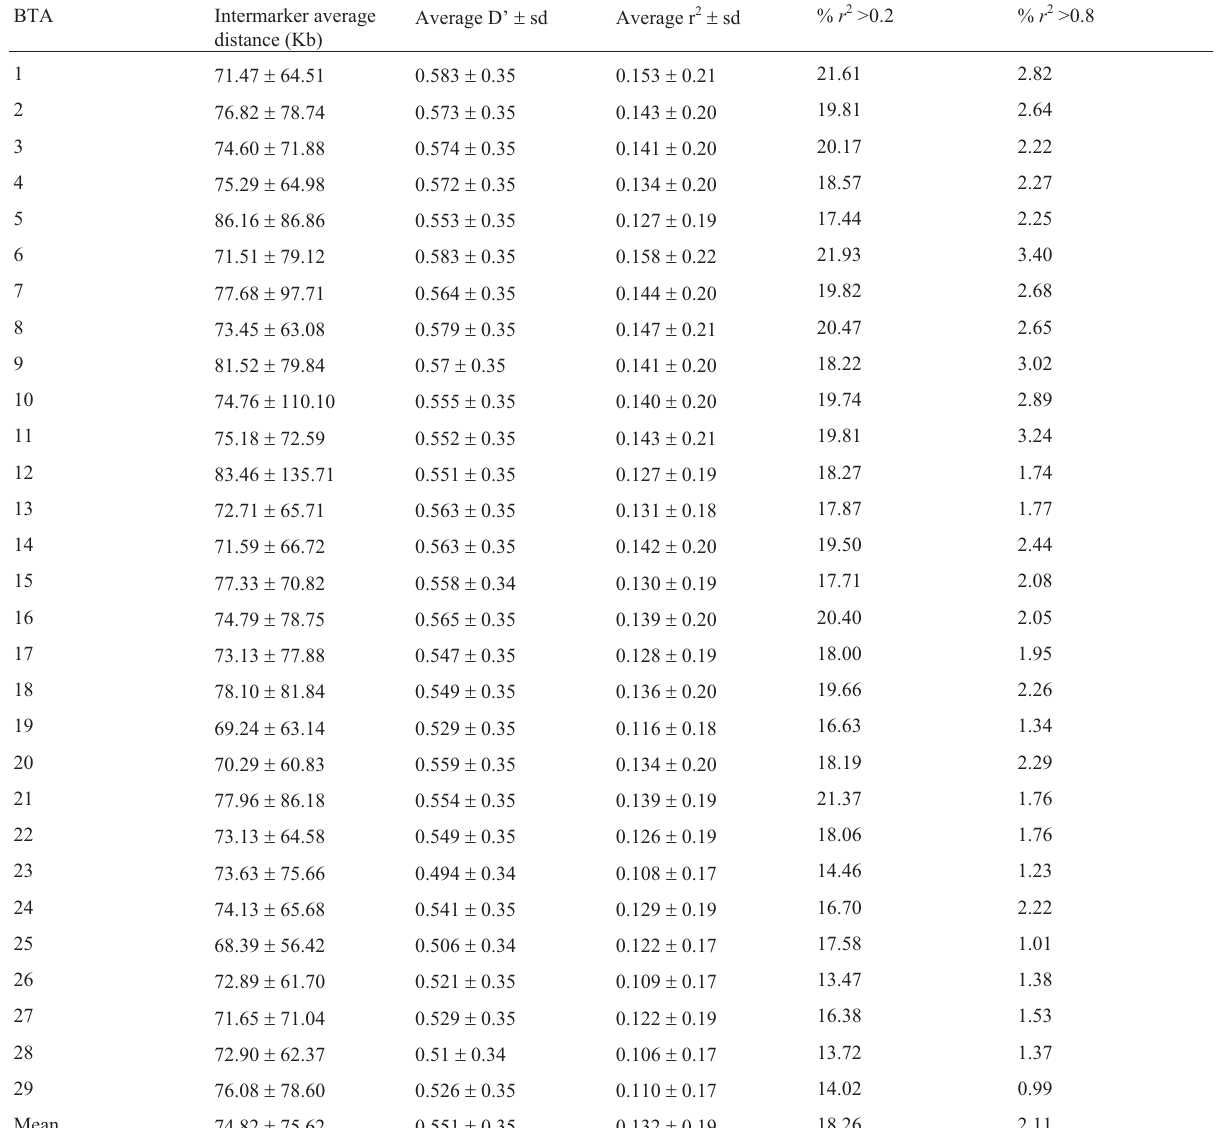
Table 2 - Mean r 2 and D’ between adjacent SNPs on each chromosome in Tunisian native cattle and percentage of marker pairs with r 2 >0.2 or 0.8. BTA Intermarker average distance